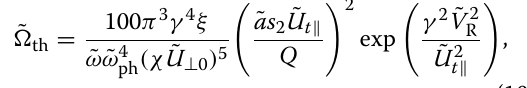
/ c U where s 2 is given by (40) with v 0 /γ . The param- = ˜ ⊥ ⊥ eters with tilde are normalized values as used in (97). The parameter of the parabolic magnetic field is normalized ac 2 /� 2 as ˜ a e0 . The wave amplitudes and frequencies = � th /� e0 and ω ω/� e0 . are normalized by (cid:31) e0 as ˜ � th = ˜ = The velocity and momentums are normalized by the U V R / c and speed of light c as ˜ V R 0 = U 0 / c . In ˜ = ⊥ ⊥ Fig. 6b, we plot the optimum wave amplitude in solid lines and the threshold amplitude in dashed lines for different values of the plasma frequency ω pe /� e 2 = (blue), 4 (green), and 8 (red) with the same parameters of energetic electrons assumed in the linear and nonlin- ear growth rate calculation in Fig. 6a. The optimum wave amplitude becomes higher in the lower frequency range with higher plasma